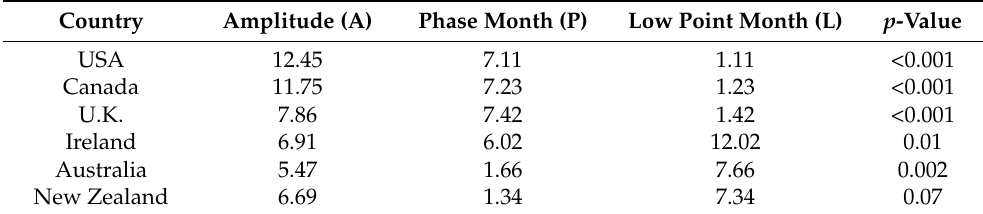
Table 2. Country-wise seasonal variations in search volume data for “heel pain” using Google Trends.